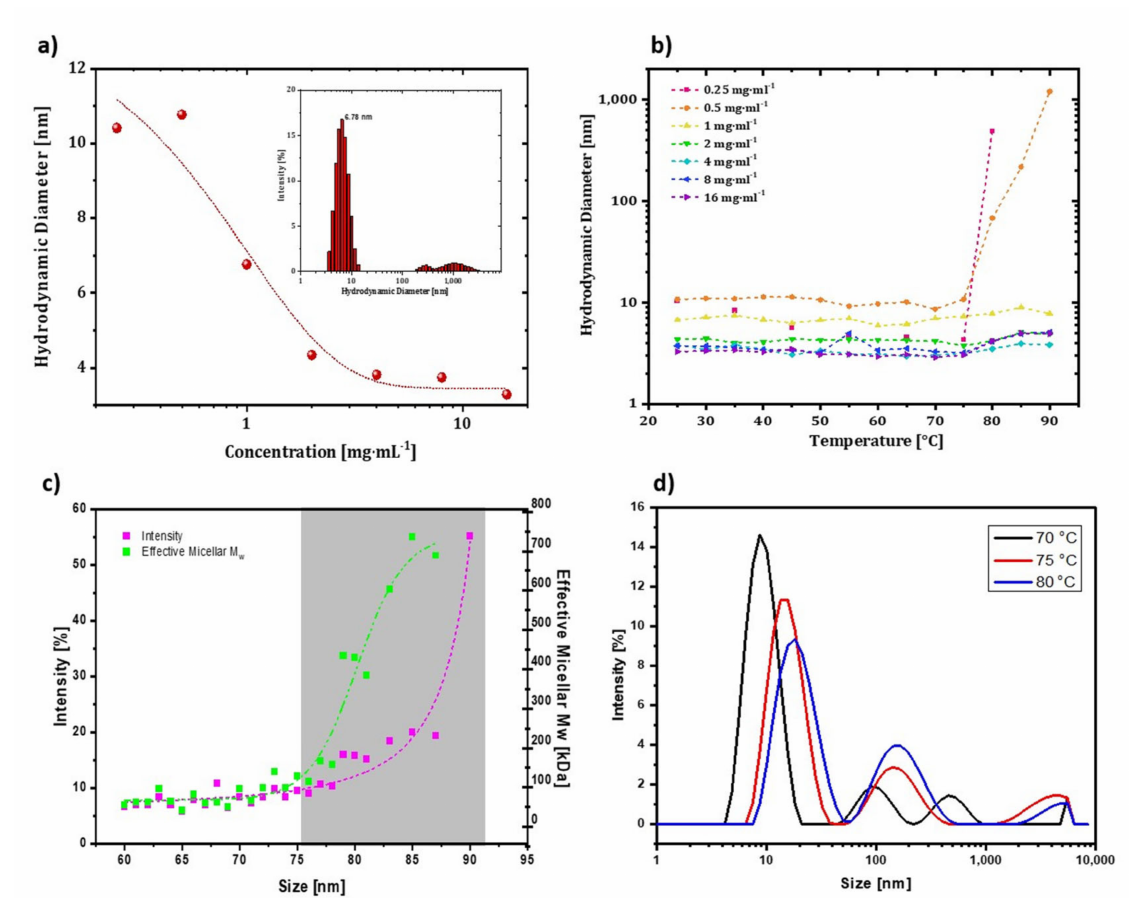
Figure 5. ( a ) The corresponding hydrodynamic diameters to antibody concentrations between 0.25–16 mg · mL − 1 . Red dots represent the hydrodynamic sizes of trastuzumab at different concen- trations. Inset: The intensity-based size measurement (d · nm) of trastuzumab at 20 ◦ C. ( b ) Intensity- based hydrodynamic diameter change of 0.25, 0.5, 1, 2, 4, 8, 16 mg · mL − 1 trastuzumab with 5 ◦ C tem-perature ramps within 25–90 ◦ C. ( c ) The temperature-ramped DLS measurement of 0.2 mg · mL − 1 trastuzumab within the temperature range of 60–90 ◦ C by varying 5 ◦ C steps. ( d ) The intensity-based hydrodynamic diameter changes of trastuzumab at 70–75–80 ◦